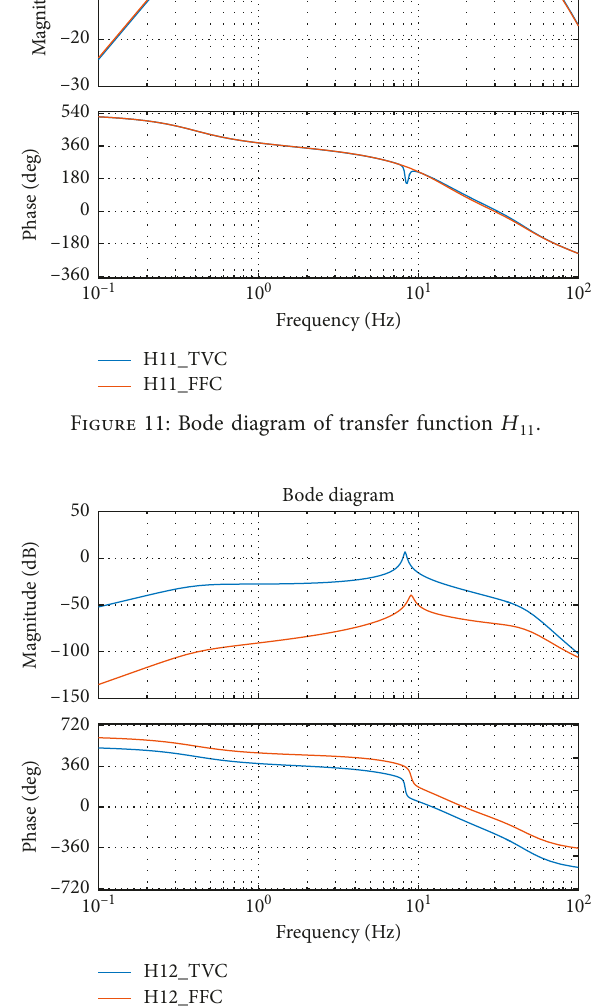
Figure 12: Bode diagram of transfer function H